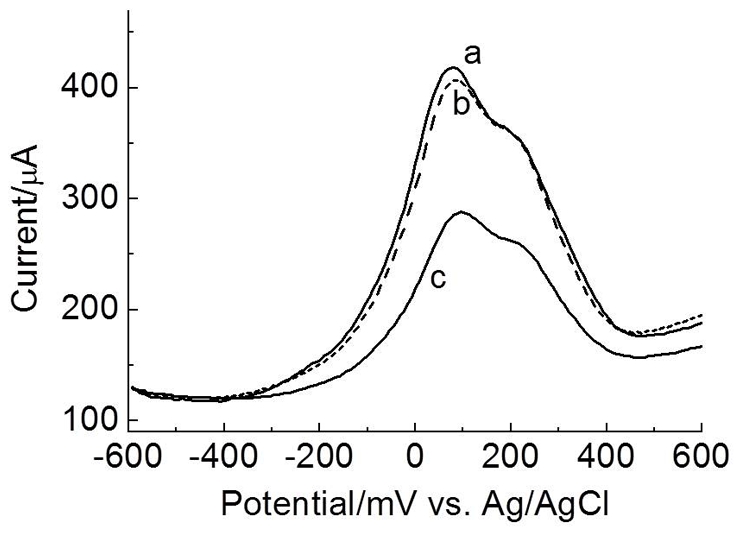
Differential pulse voltammograms of graphite electrode modified with poly(3-HPA).Synthetic peptide Am1 (A) before or after addition of negative serum (IgG−) (B) or positive serum (IgG+) (C), in aqueous solution containing K3Fe(CN)6/K4Fe(CN)6 (0.33 mmol.L−1) and KCl (0.1 mol.L−1). Modulation amplitude: 25 mV; 16 mVs−1.